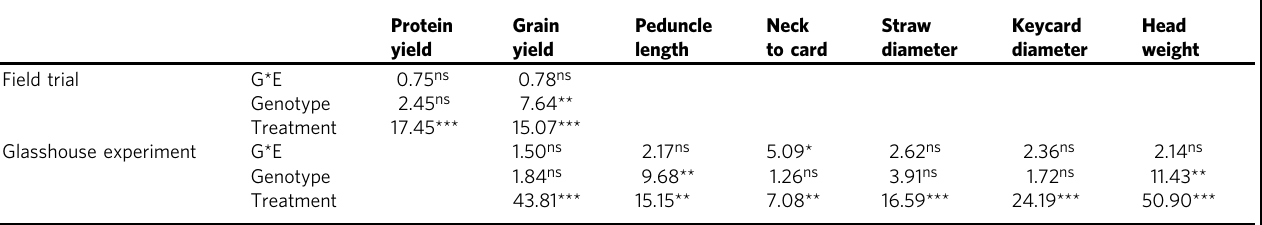
Table 1 Univariate analysis of variance of the impact of the genotypes (G), sulfur treatments (E) and G×E on agronomically important traits in 2014 fi eld trial and glasshouse experiment.